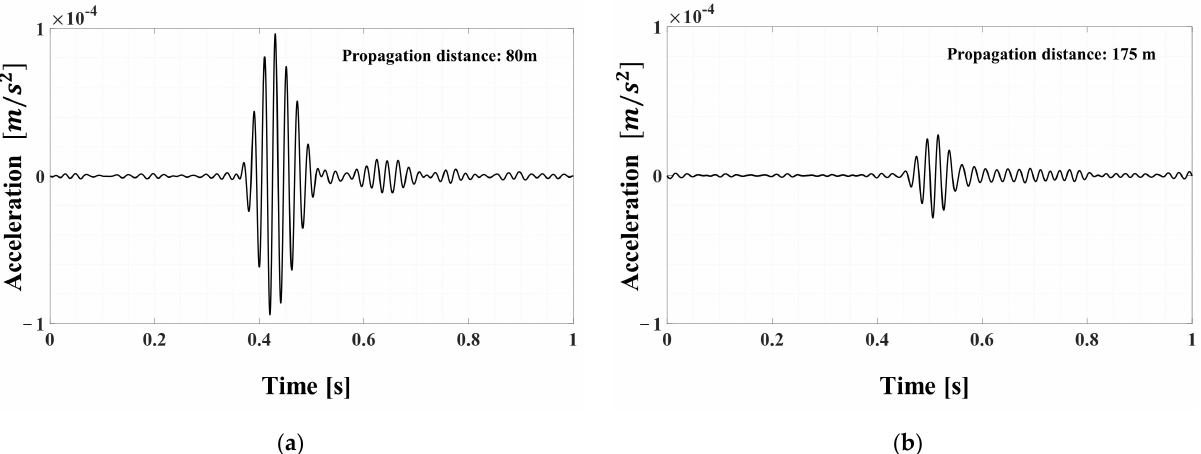
Figure 17. Time-domain signal obtained after the optimal bandpass filter process: ( a ) sensor 1 and ( b ) sensor 2.